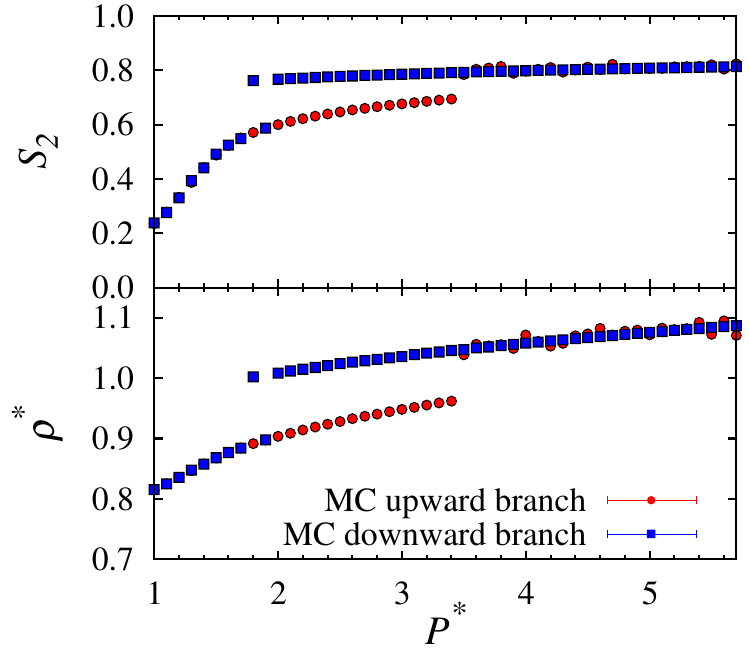
Figure 1. Plots of nematic order S 2 ( top ) and number density ρ ∗ ( bottom ) versus pressure P ∗ for upward and downward branches using conventional MC at T ∗ =